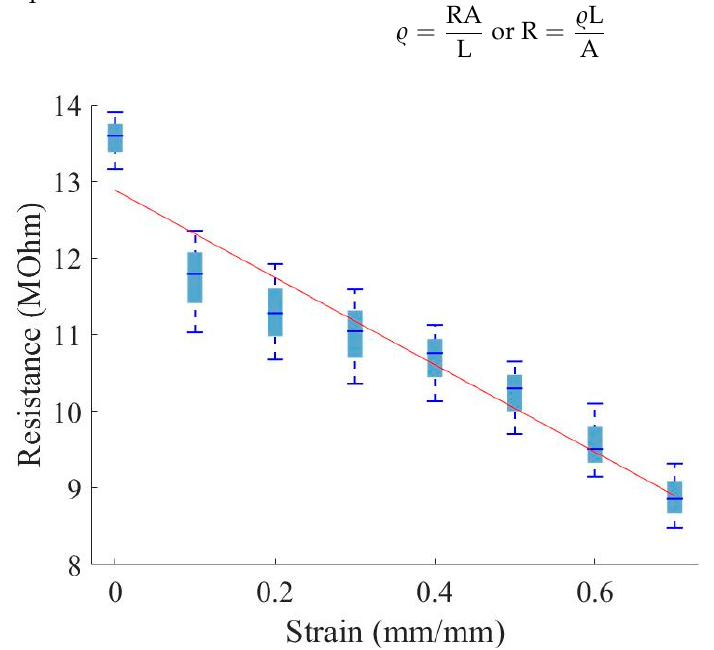
Figure 9. Distribution of resistance versus strain; resistance measured through the material thickness.